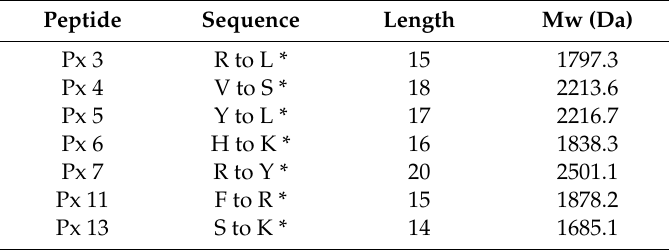
Table 1. List of the selected seven